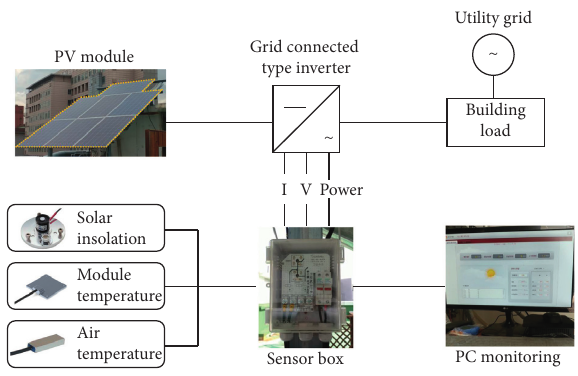
Figure 2: Schematic of the PV and monitoring systems. Table 4: PV system